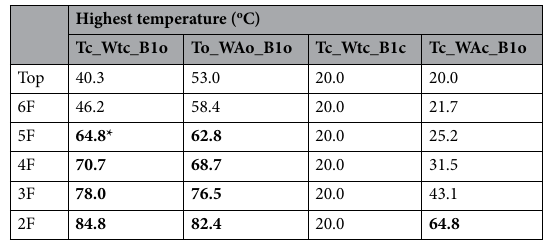
Table 6. The highest temperature at the door of the residents on each floor of No. 2 staircase. *Bold value indicate that the value exceed the tolerable temperature of the human (60 °C).